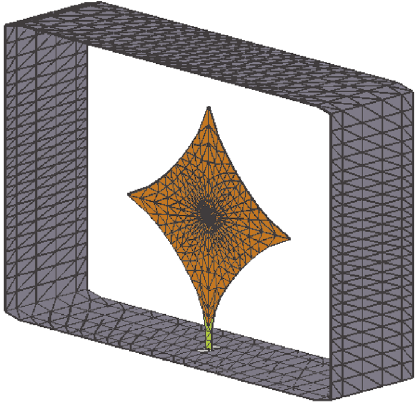
Figure 3: An example of triangulated antenna